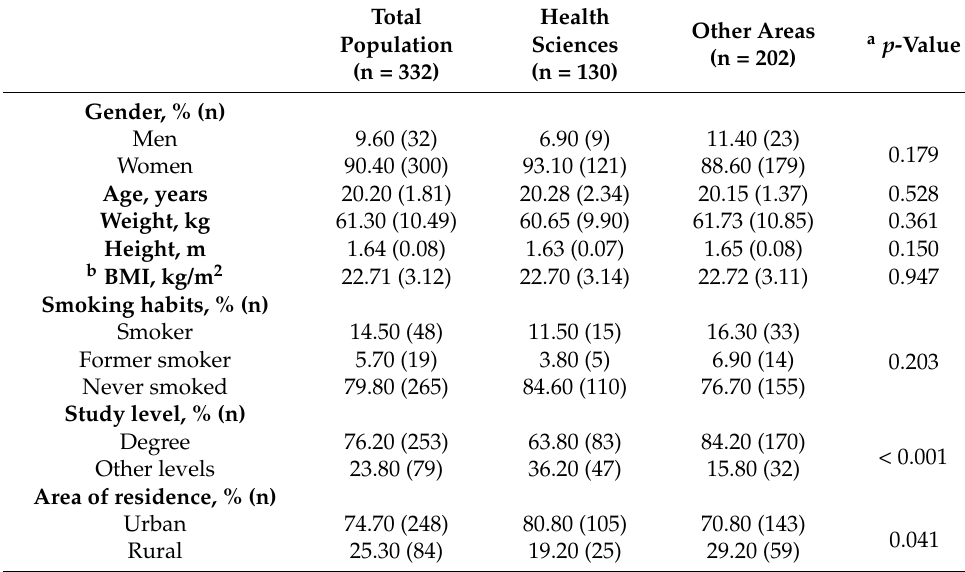
Table 1. General characteristics of the studied population, according to the study